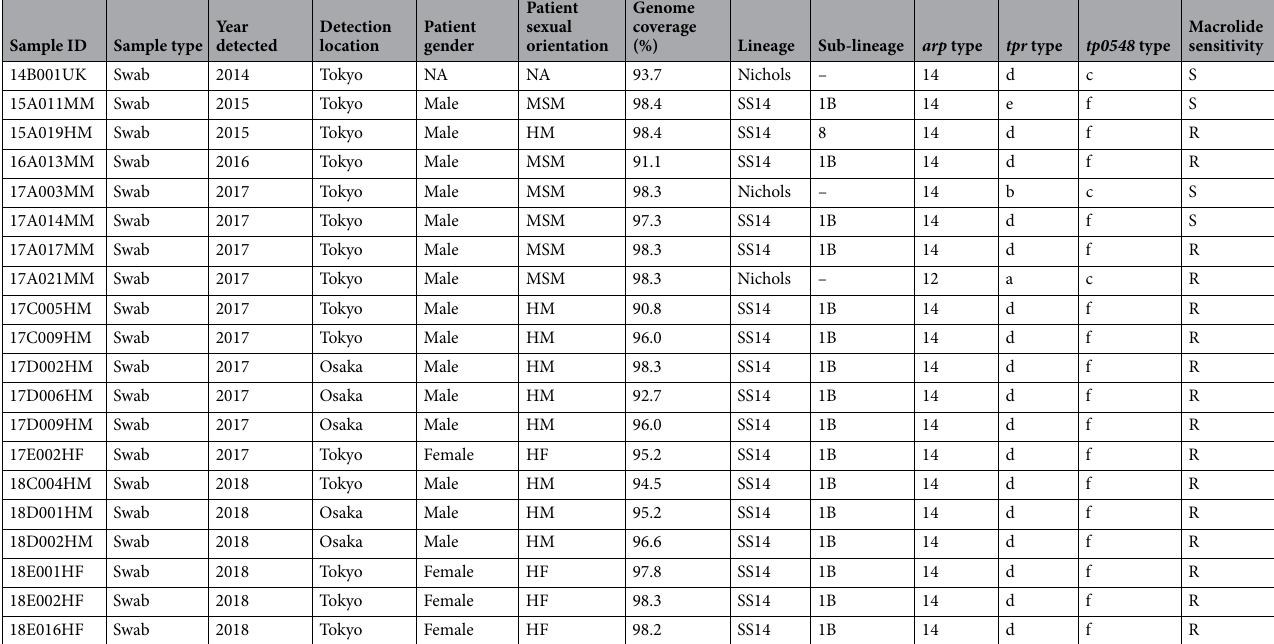
Table 1. Clinical information and molecular typing results of 20 Japanese Treponema pallidum subspecies pallidum strains. NA, data not available; MSM, men who have sex with men; HF, heterosexual female; HM, heterosexual male; S, sensitive; R,